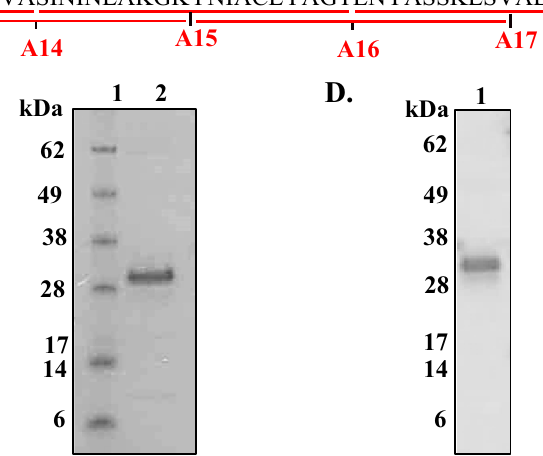
Figure 1. Characteristics and production of protein and peptides. ( A ) Domain organization of Mru_1499 of Methanobrevibacter ruminantium M1. Predicted domain architecture using SMART database and InterPro 22–24 . Signal peptide (SP) encoded by amino acids 1–18, four bacterial immunoglobulin class 1 (Big_1) domains and transglutaminase (TG) domain are represented as pink, grey and green rectangles, respectively. Numbers represent the amino acid residues in the protein sequence. ( B ) Schematic presentation of peptide design of AdLP-D1. Peptides of twenty amino acids long with 10 amino acids overlap are shown as red lines under the residues with the peptide designations in red. ( C ) Purified AdLP-D1 analyzed using SDS-PAGE, stained with Coomassie blue. Lane 1, SeeBlue Plus2 Pre-Stained Standard (Invitrogen, Carlsbad, CA, USA); lane 2, purified fraction of AdLP-D1. The complete gel is shown in Supplementary Fig. 1. ( D ) Western blot analysis of AdLP-D1 purified fraction using anti-hexahistidine-tag antibodies. The complete gel is shown in Supplementary Fig.